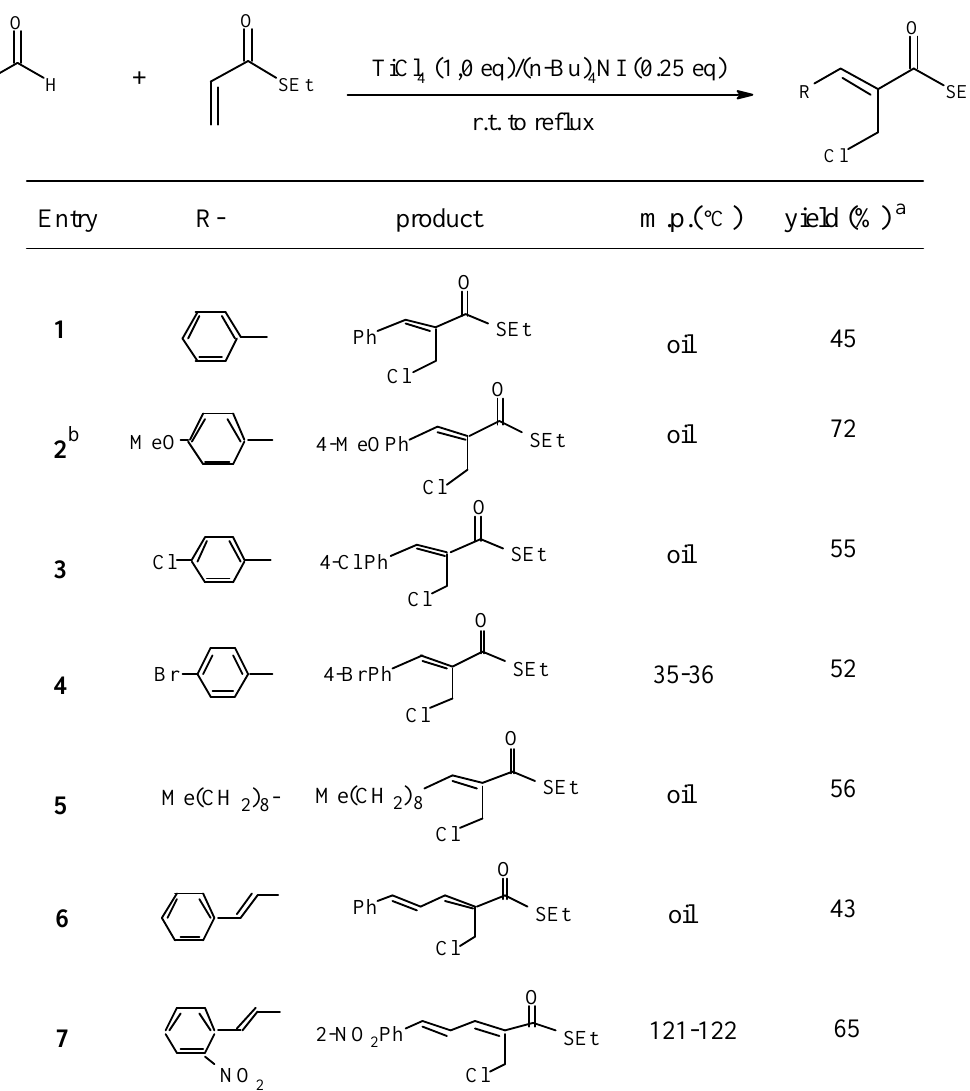
Table 1. Results of TiCl